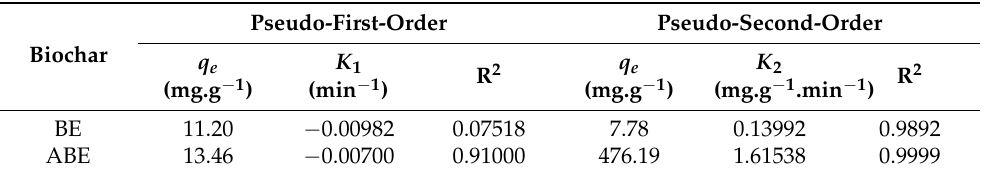
Table 2. Adjustment to Langmuir and Freundlich isotherm model for biochar (BE) and activated biochar (ABE).